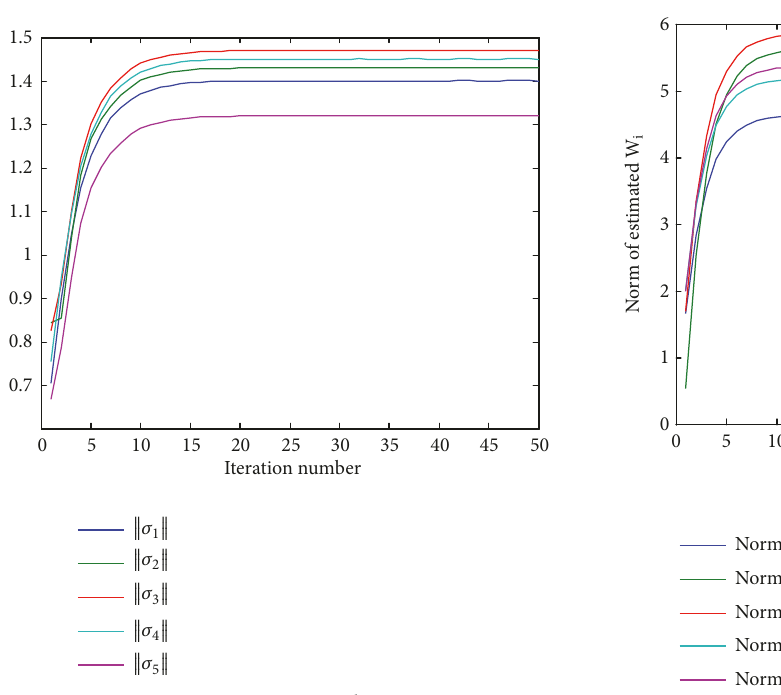
Figure 5: Response of 𝜎 𝑘 𝑖 (𝑡) .